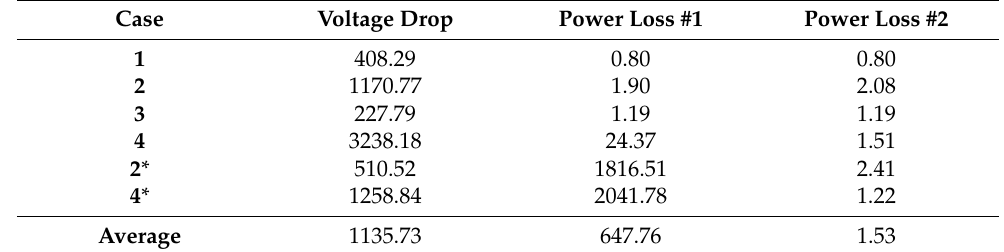
Table 4. Comparison of the two-norm error matrices, || Y Aggr . − Y modal || 2 , in milisiemens.